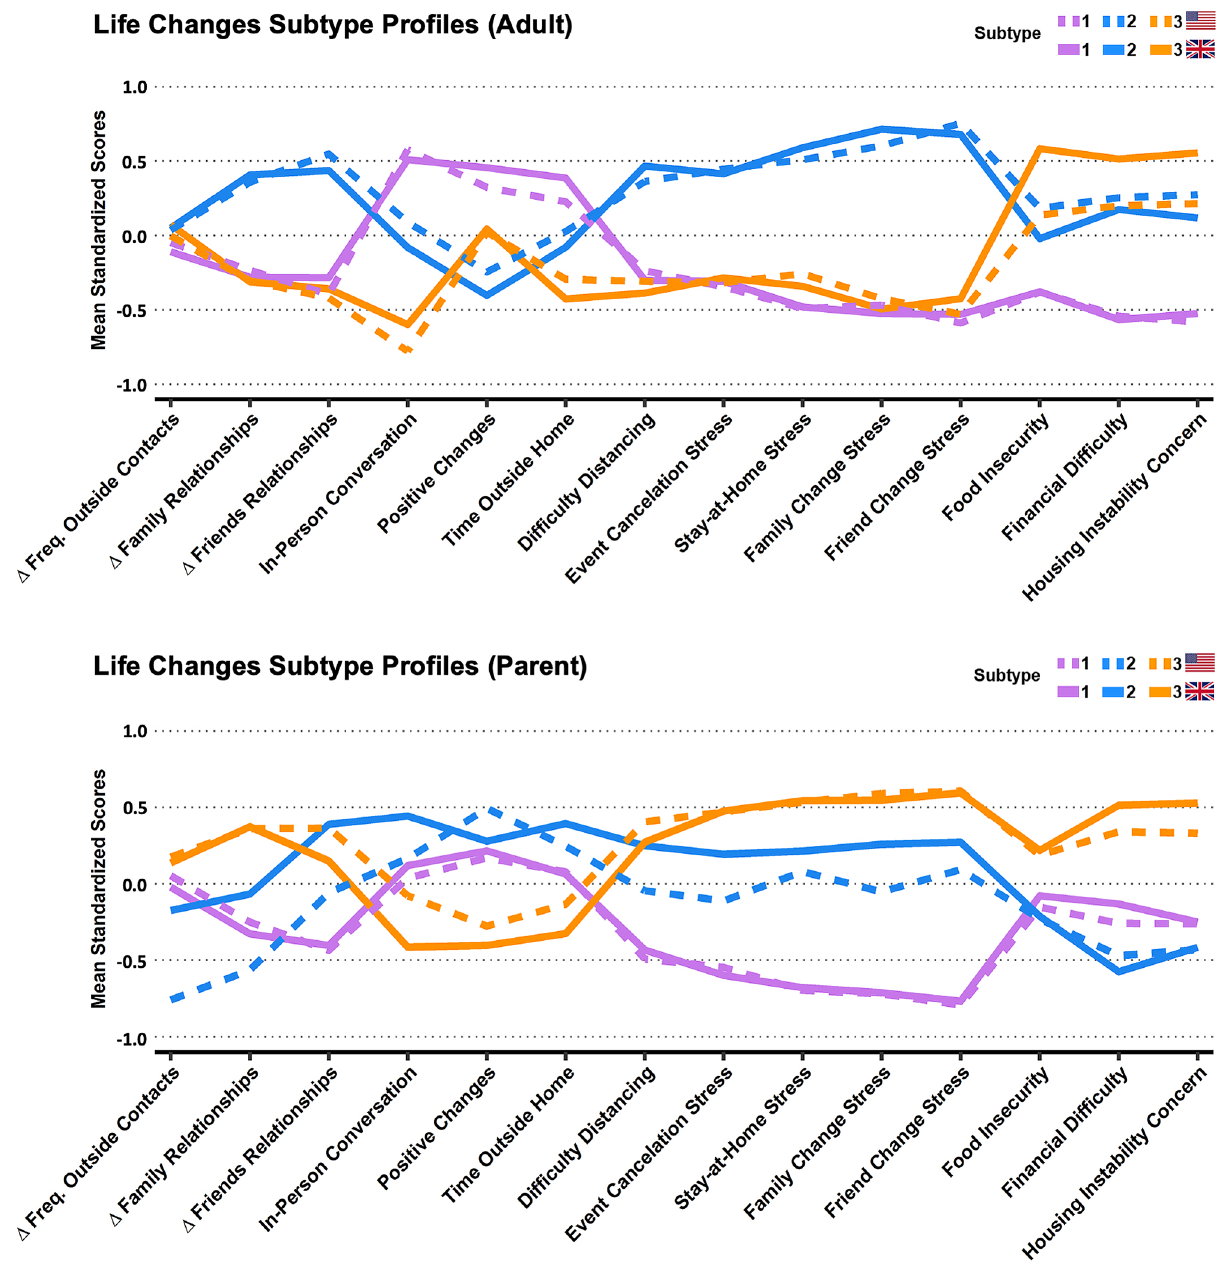
(1): low stress , Blue (2): social/interpersonal stress , Orange (3): economic stress. Parent-Report Subtypes: Purple (1): low stress , Blue (2): social stress, Orange (3): social/economic stress Notes: ∆ Family Relationships and ∆ Friends Relationships are coded so that higher scores indicate worsening quality of relationships. Prior to the community detection analyses In-Person Conversation was re-coded into